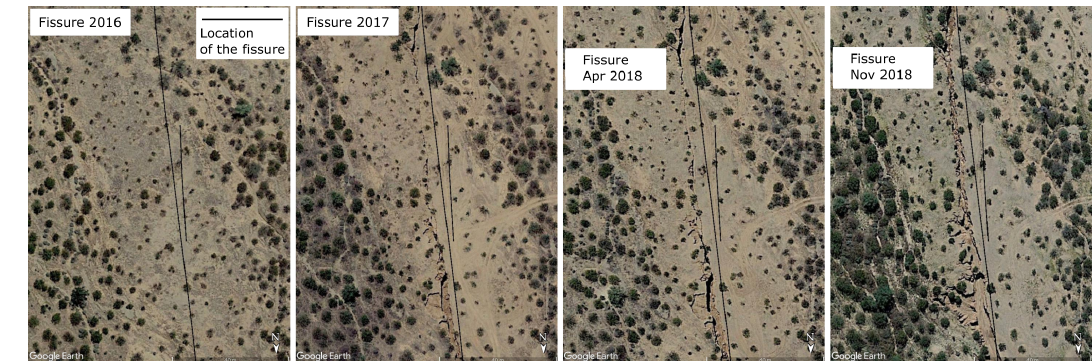
Figure 2. Evolution of the earth fissure since 2016 to 2018. Source: © Google